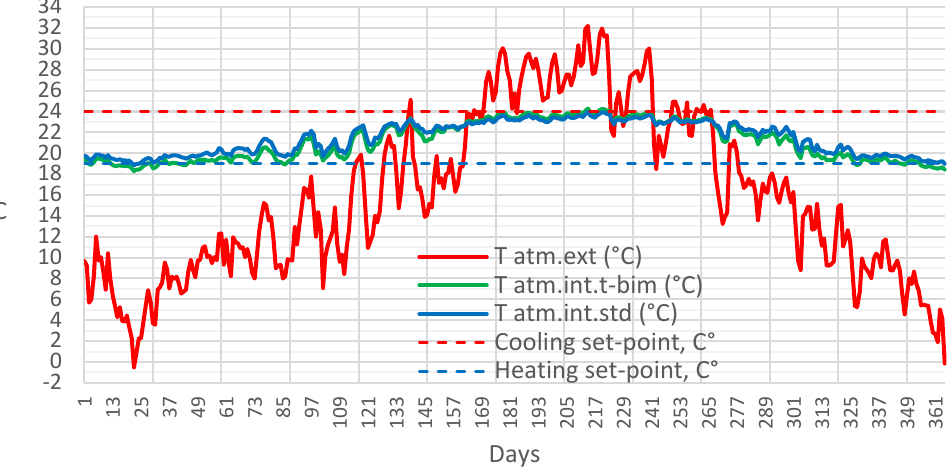
Figure 11. Daily temperatures of indoor air in all zones are average according to the simulation results of the as-is STD and as-is T-BIM models and the average daily outdoor temperature of the typical meteorological year TMY 2007–2021 used in the simulations of both models.